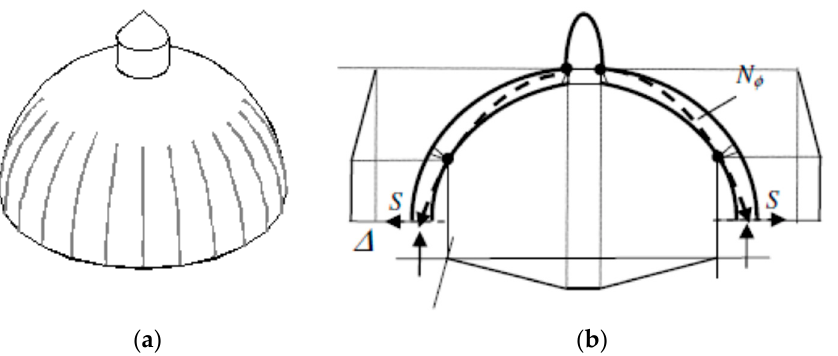
Figure 2. ( a ) Typical meridian cracks; ( b ) dome slice with increased span due to springer setting.